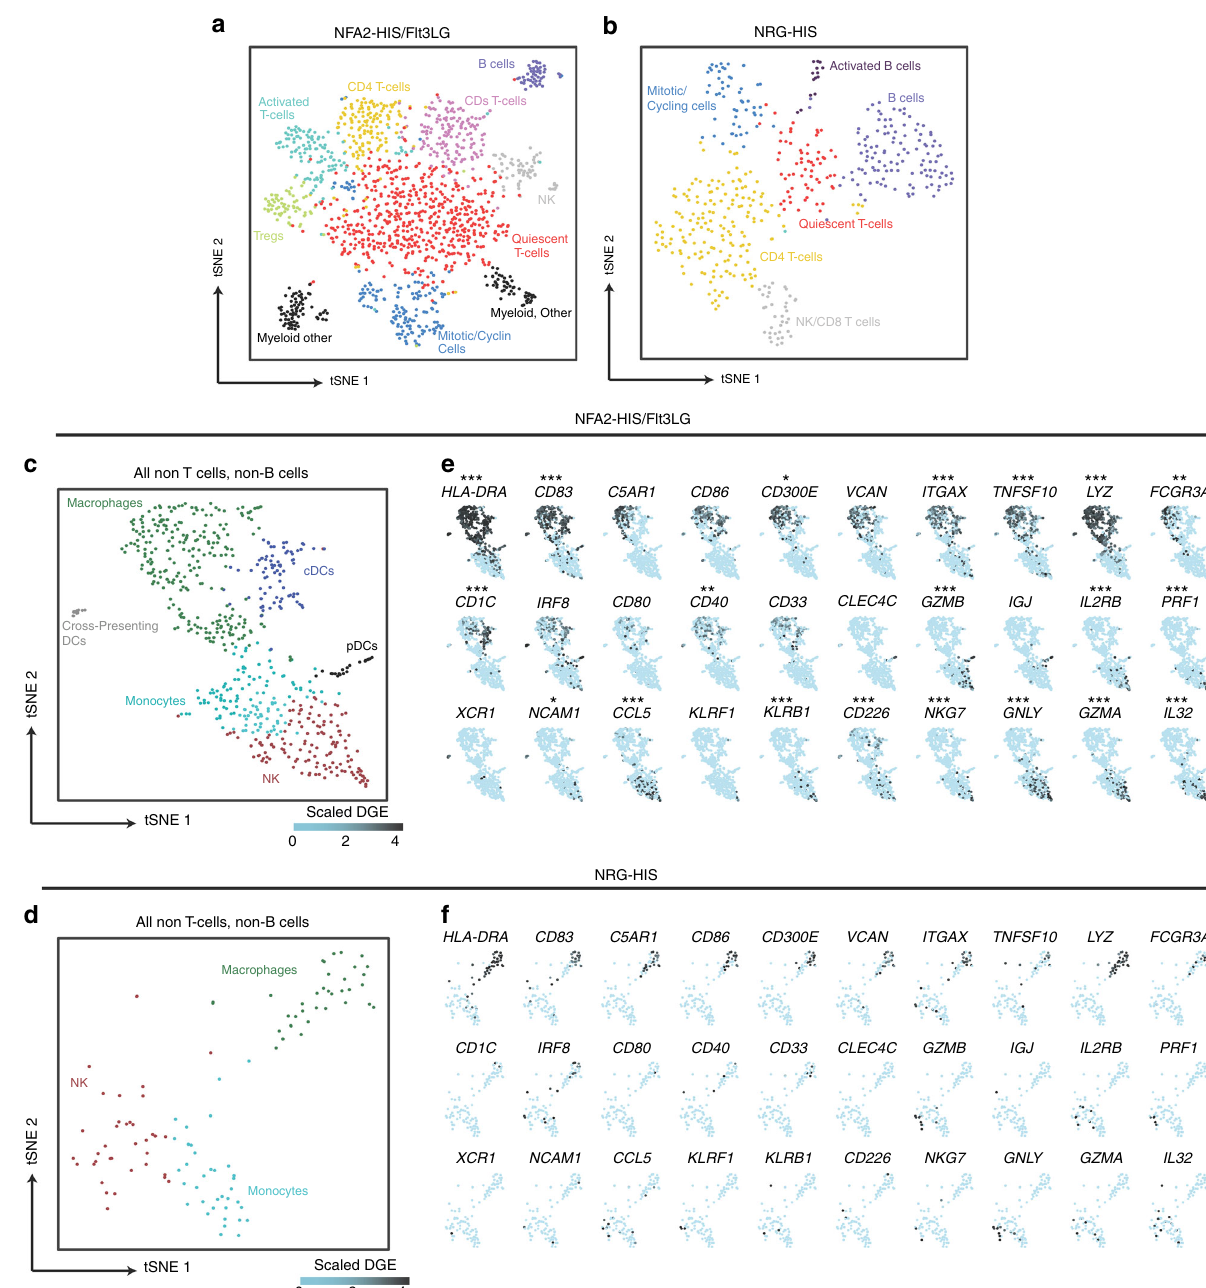
Fig. 8 Improved human immune system complexity in NFA2-HIS/Flt3LG. a , b 1297 and 457 single cells from the CD45 + compartment in NFA2-HIS/ Flt3LG ( a ) and NRG-HIS ( b ) mouse spleens respectively, 6 weeks post infection. Single cells are plotted using t-stochastic neighbor embedding (tSNE). Signi fi cant clusters were de fi ned using a shared nearest neighbor modularity based clustering algorithm 67 . Clusters identi fi ed by de fi ning signi fi cantly differentially expressed genes in each cluster using a likelihood ratio test for single-cell gene expression and annotating by literature-supported gene expression programs or subpopulation de fi ning genes (see Methods section). c , d CD3-CD79-TCR-BCR- single cells from both CD45 + and CD33 + compartments in spleens from two NFA2-HIS/Flt3LG ( c ) and NRG-HIS ( d ) mice are plotted as a tSNE. Clustering and annotation are completed as described in ( a , b ). e , f Cluster-de fi ning genes over CD3-CD79-TCR-BCR- single cells from NFA2-HIS/Flt3LG ( e ) and NRG-HIS ( f ) mice are represented as a projected color scale on the tSNE calculated in ( c ) and ( d ), respectively. Scaled digital gene expression is represented as a color map from light blue (low gene expression) to black (high gene expression), and these values are projected onto the single cell point. The expression of these genes in NFA2-HIS/ Flt3LG mice ( e ) was compared to the expression in NRG-HIS mice ( f ), and signi fi cantly differentially expressed genes are shown in ( e ) (* p ≤ 0.05, *** p ≤ 0.001; Benjamini – Hochberg adjusted p -value). Tregs regulatory T cells, NK natural killer cells, DCs dendritic cells, cDCs conventional dendritic cells,